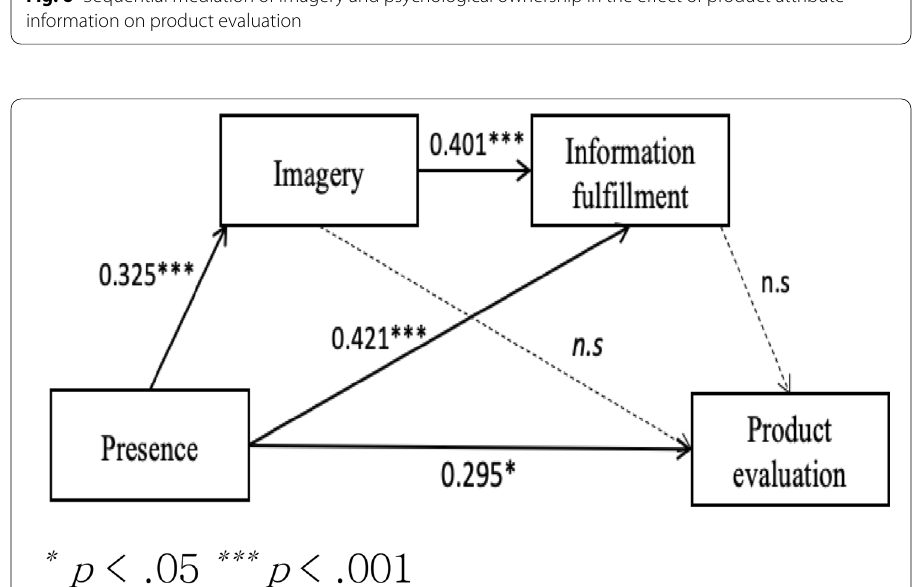
Fig. 7 Sequential mediation of imagery and information fulfillment in the effect of presence on product